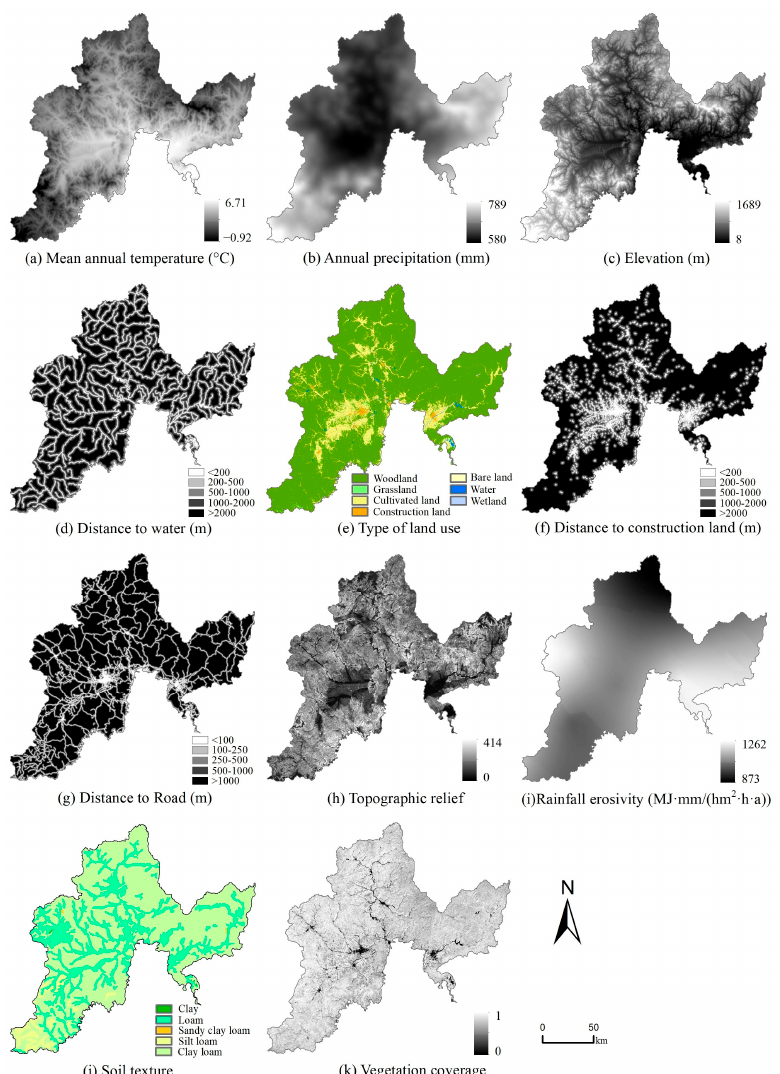
Figure 2. Maps of the evaluation factors.